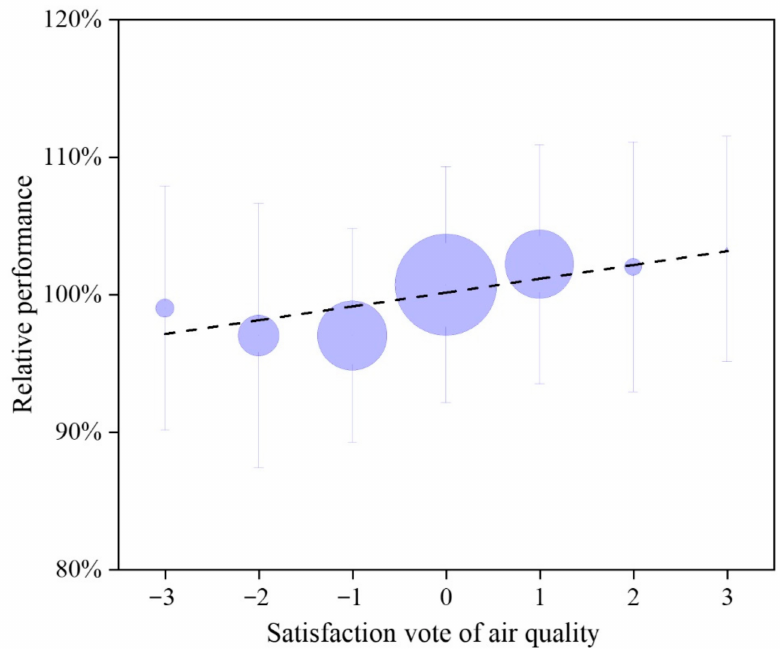
Figure 12. The quantitative relationship between relative performance and satisfaction vote of air quality. The size of circle represents the corresponding sample